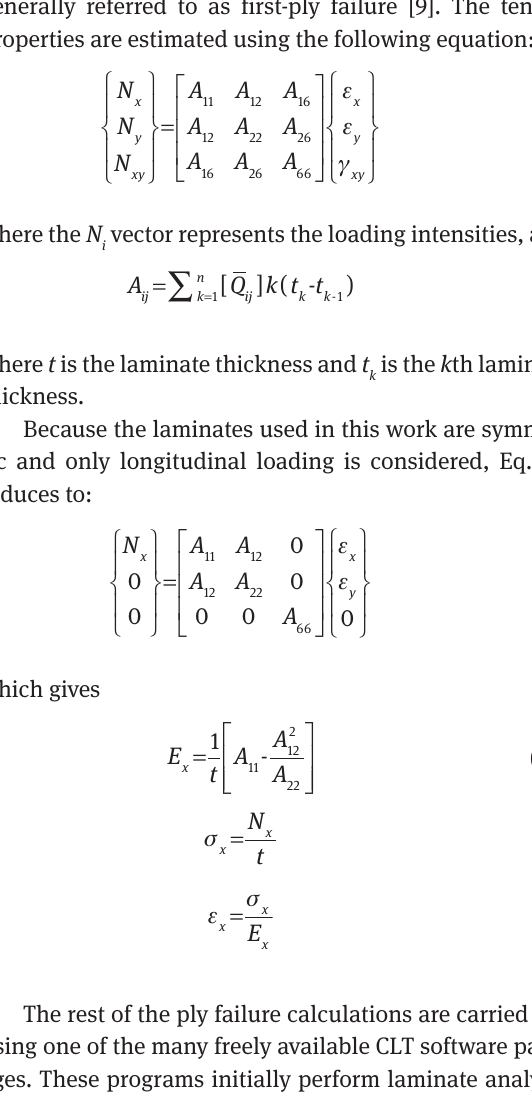
Figure 2 Stress vs. strain curves for [+67.5